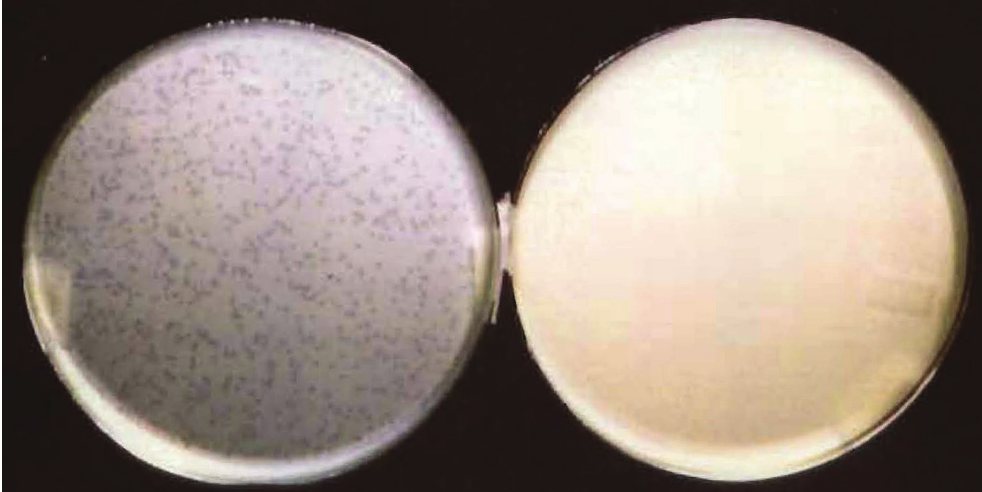
Figure 3. λ infection of HBT and HBT(pOri1) on agar plates. About 1000 λ particles were tittered on agar plates containing either HBT (left plate) or HBT(pOri1) (right